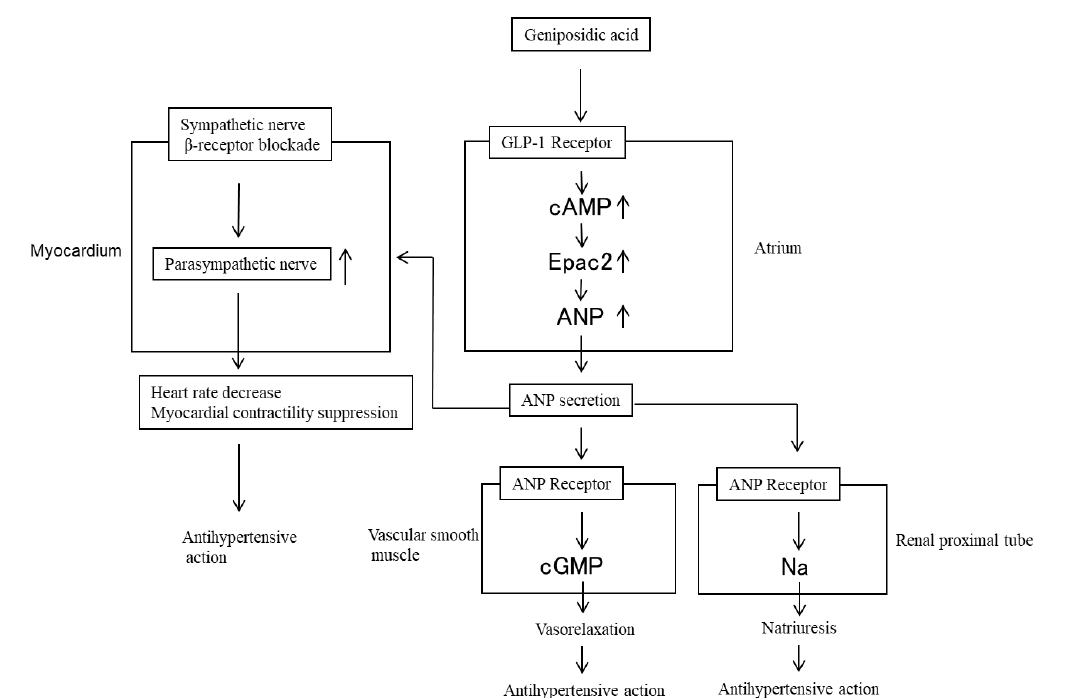
Figure 4. Antihypertensive mechanism of action of ELE resulting from atrial natriuretic peptide (ANP) secretion by GEA in rodents; cGMP: guanosine 3′ , 5′ -cyclic monophosphate; cAMP: cyclic adenosine monophosphate. Small arrows next to words indicate the increases or decreases in the action or secretion.